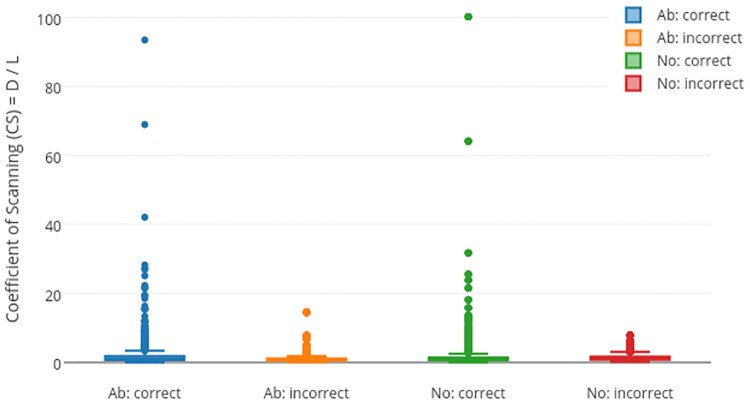
CS values for 2240 responses.